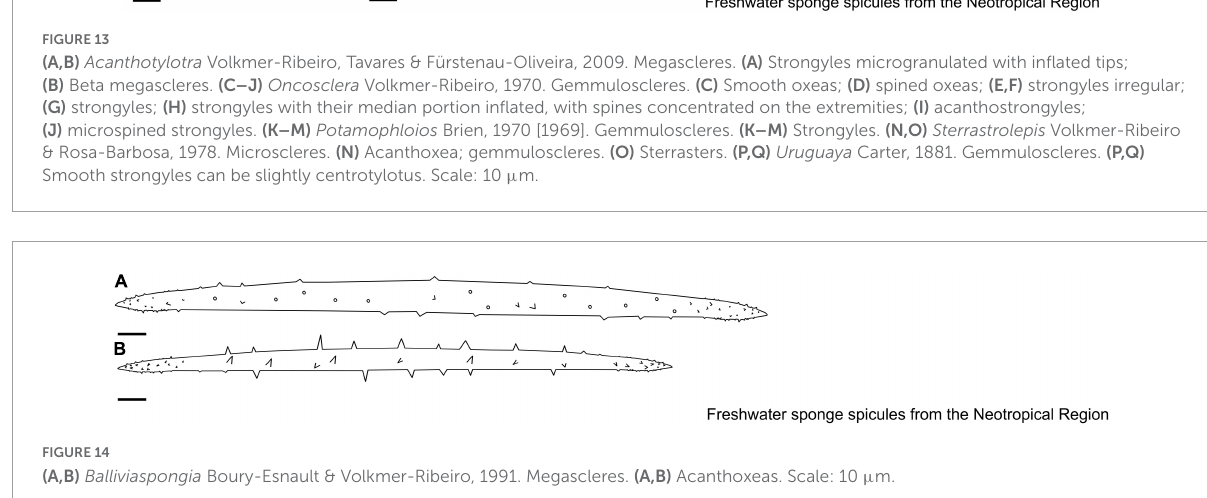
ellipsoid sterrasters, with an irregular surface apart from a unilateral smooth area ( Figure 13O